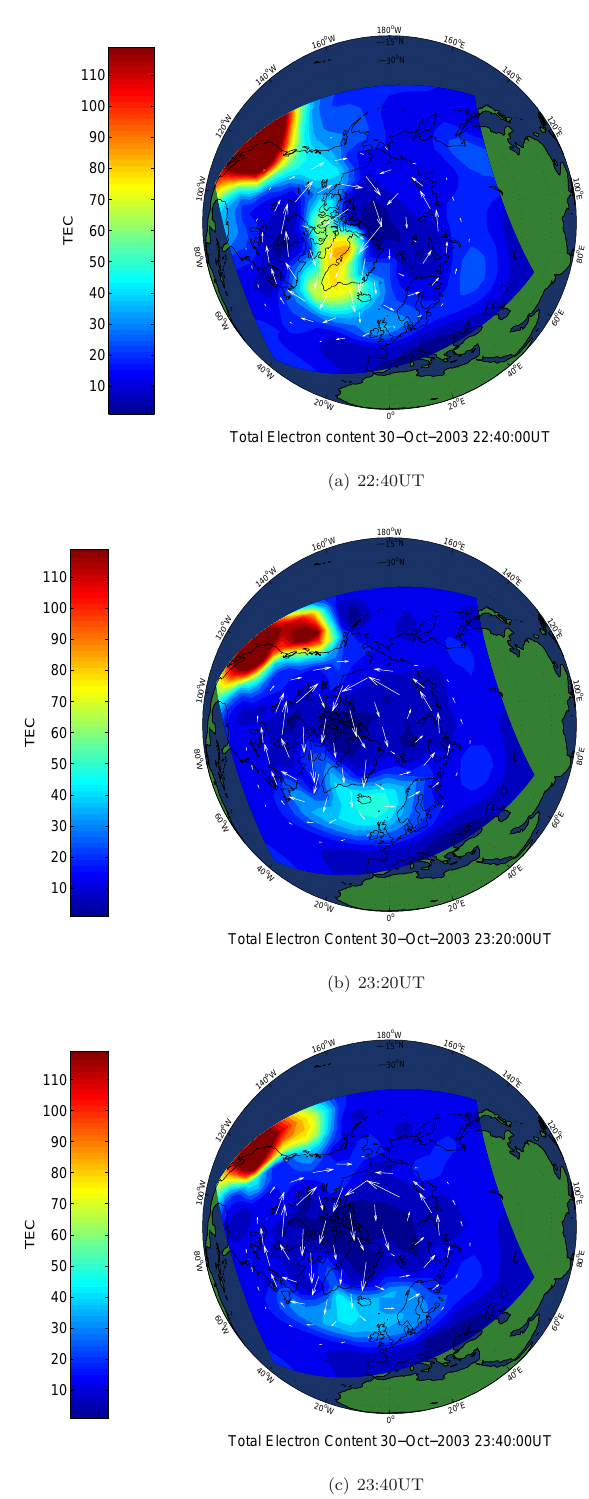
Fig. 6. GPS TEC maps (in TECu) over the Northern Hemisphere for the period of (a) 22:40UT, (b) 23:20UT and (c) 23:40UT on 30 October